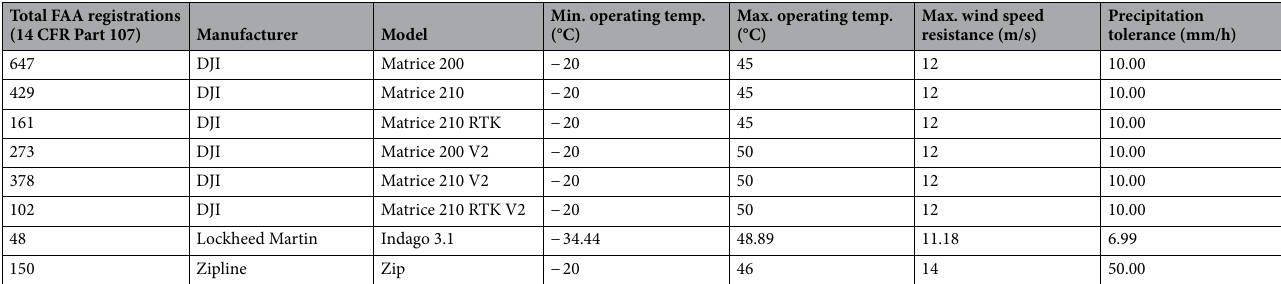
Table 2. Small drones commercially registered in the United States as of 05 May 2020 with precipitation tolerance > 0.00 mm/h.